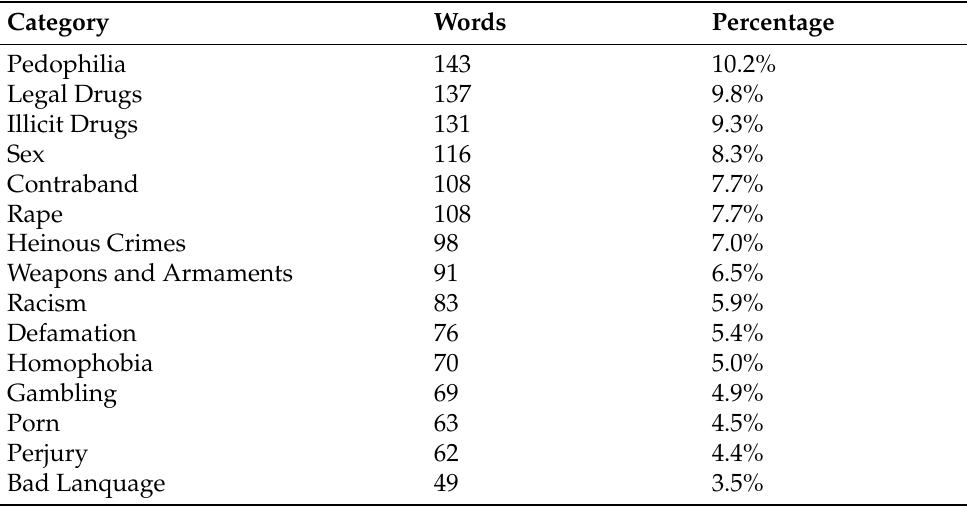
Table 2. Number of words per category in